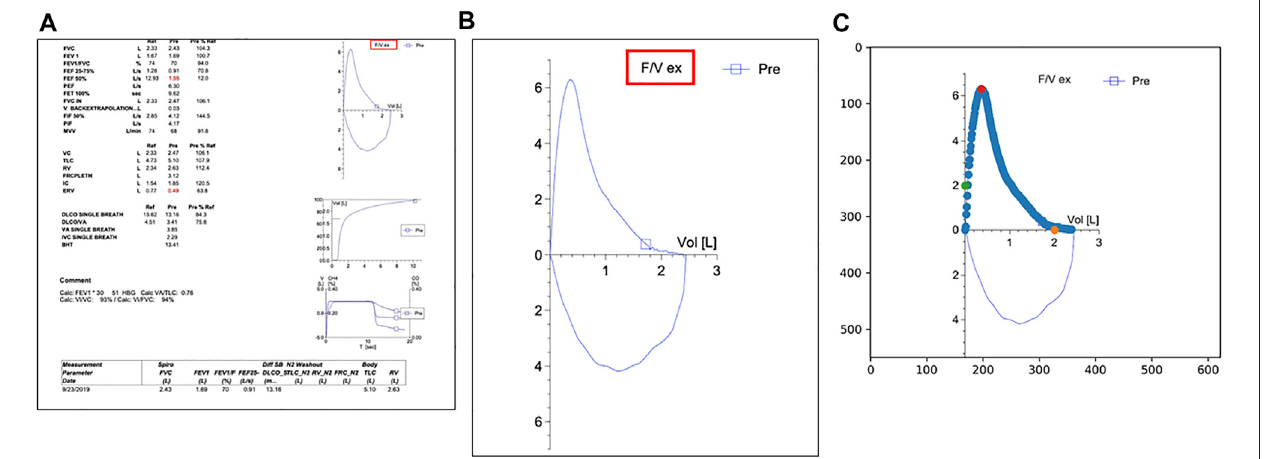
FIGURE 1 | (A) A typical PFT report in the electronic medical record system used by Duke University Medical Center (EPIC). The label highlighted by the red box is used asanidenti fi ertolocatethe fl owvolumeloop(FVL)onthepage. (B) ThetargetFVLextracted bythealgorithm; (C) Thegreendotsandtheorangedotsareusedfor y -axis and x -axis alignment respectively. The red dot indicates the point of the peak expiratory fl ow.